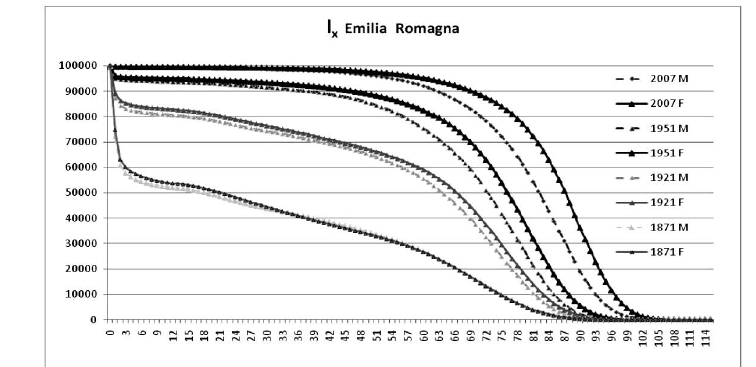
Figure 2 – Survivors l x by gender in 1871, 1921, 1951 and 2007.